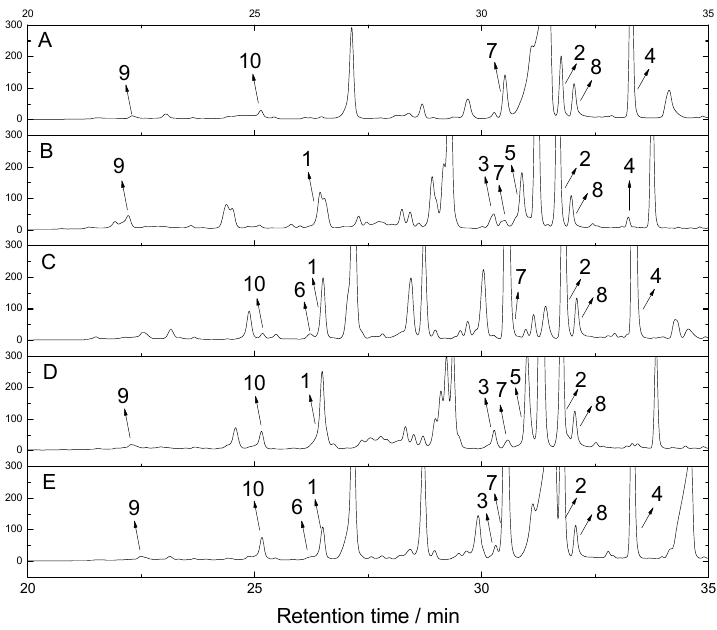
Figure 3. The HPLC fingerprints recorded at 254 nm of Aspergillus unguis fermentation extracts when cultured under different conditions . ( A ) A. unguis in potato sucrose broth (PSB) medium; ( B ) A. unguis in PSB medium + NaBr; ( C ) A. unguis in PSB medium + procaine; ( D ) A. unguis in PSB medium + procaine + NaBr; ( E ) A. unguis treat with plasma in PSB medium.